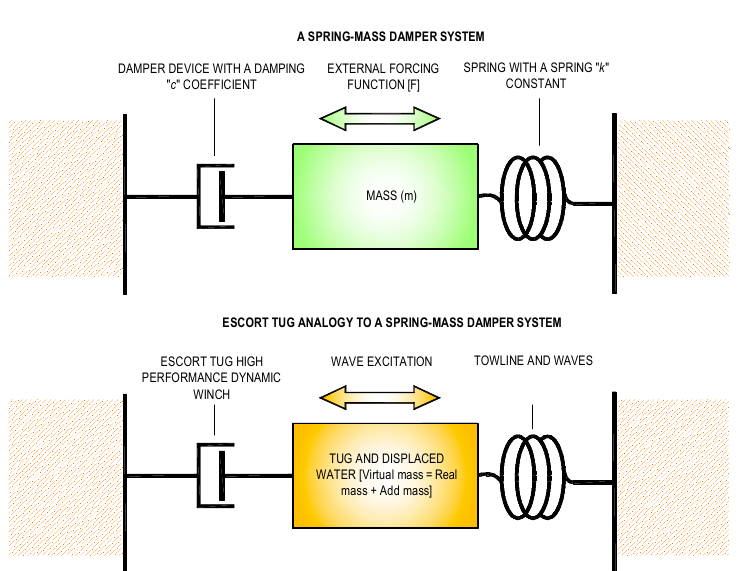
Figure 15. Analogy of an escort tug in a dynamic environment to a mechanical spring-mass damper system. Drawing: Authors.